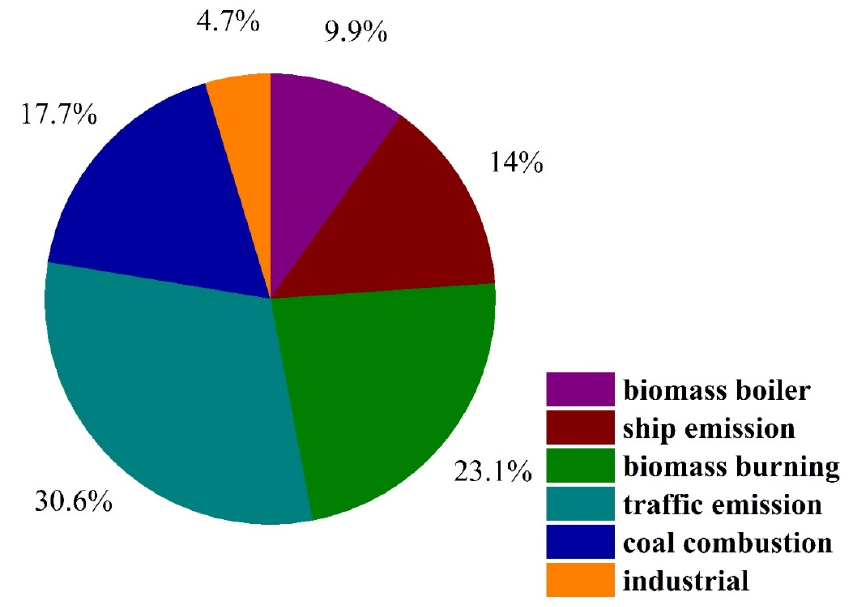
Figure5. ContributionsofeachsourcetoPM 2.5 Figure 5. Contributions of each source to PM 2.5 mass concentration after subdividing secondary aerosols.